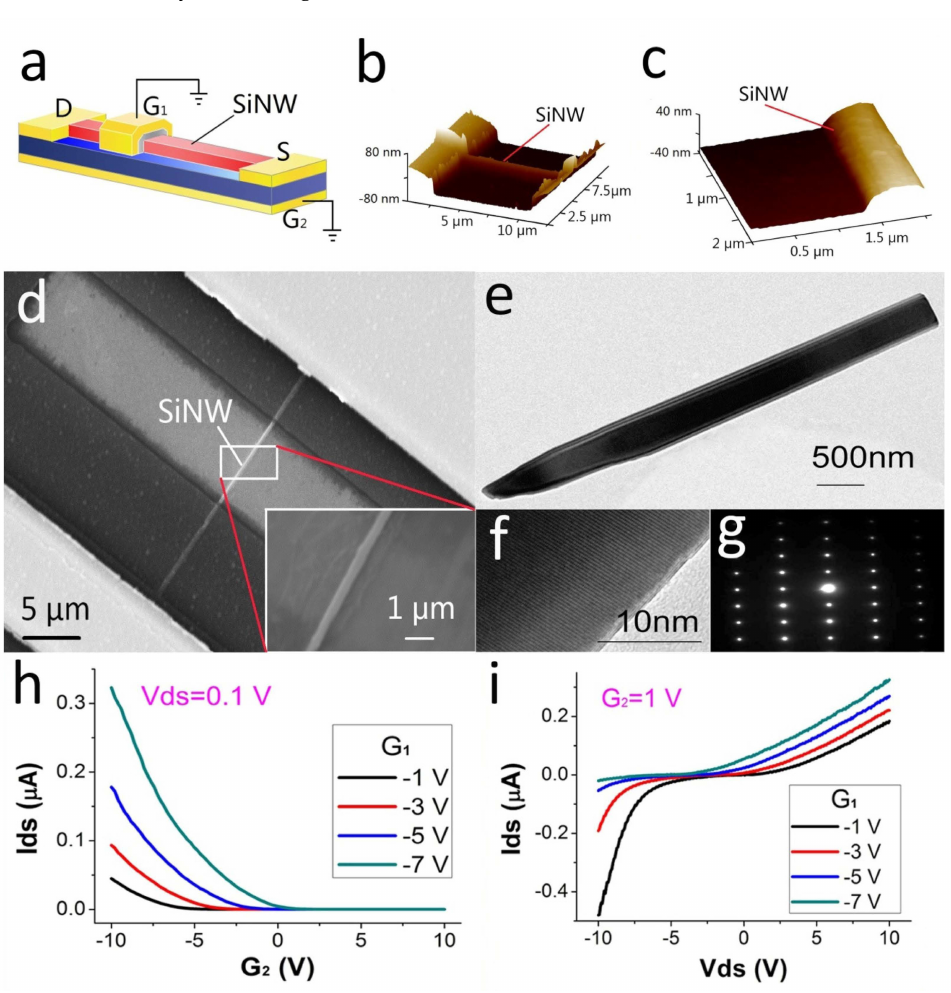
Figure 2. Fundamental properties of SiNW. ( a ) Schematic diagram of the electrode structure of the SiNW device. ( b , c ) AFM image of SiNW. ( d ) SEM image of SiNW. ( e – g ) TEM image of SiNW. ( h ) Transfer curves of SiNW device. ( i ) Output curve of the SiNW